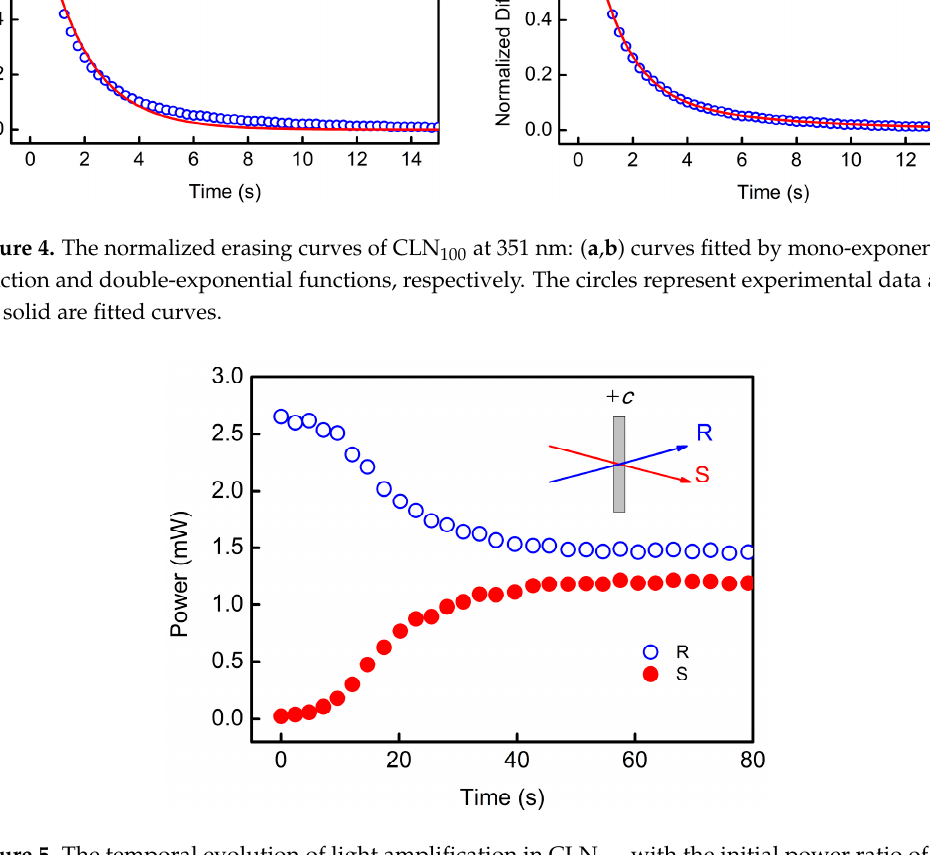
Figure 5. The temporal evolution of light amplification in CLN 100 with the initial power ratio of the transmitted S and R beams of 1:150. Table 1. Fitting parameters of the normalized erasing curves for CLN 100 at 351 nm.